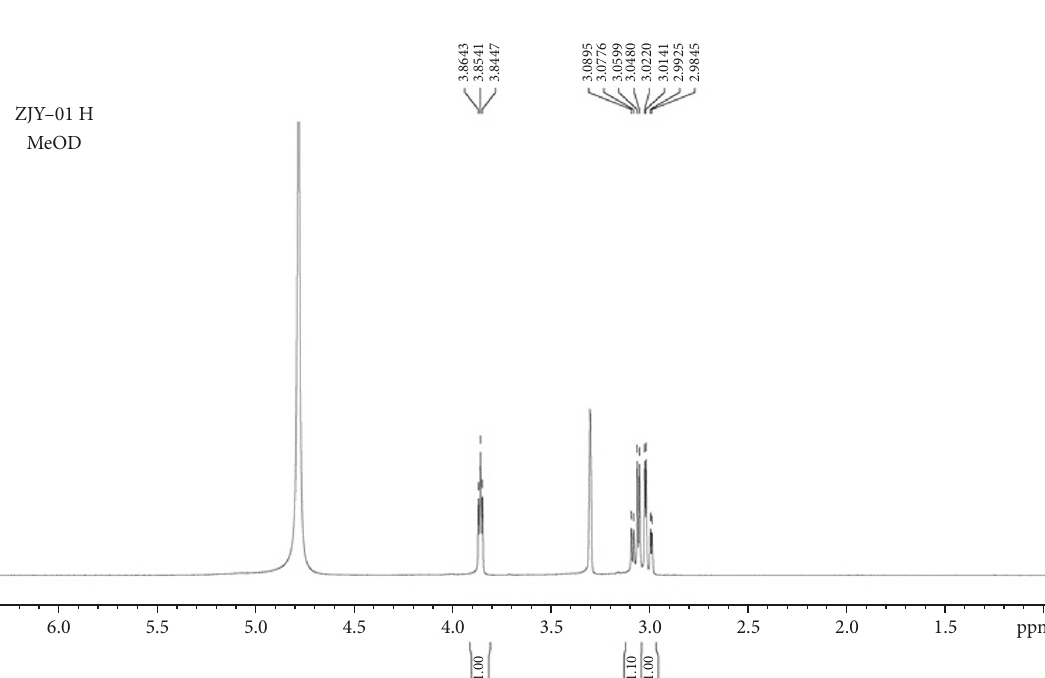
Figure 8: H-NMR spectra of Cys and DDQ in